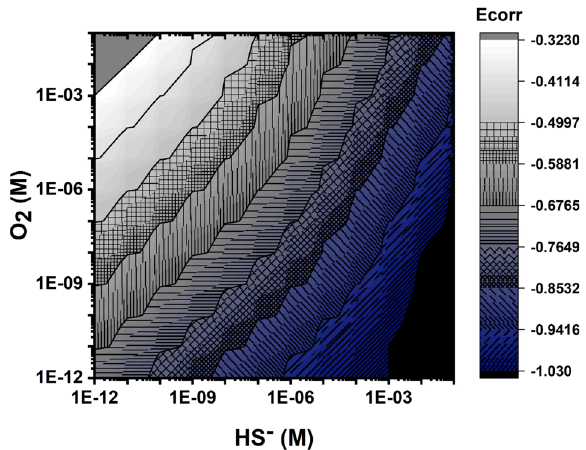
Fig. 6 Simulated corrosion potential with variables. Contour of corrosion potential ( E corr ) with concentration of HS − and O 2 by mixed-potential Eq.